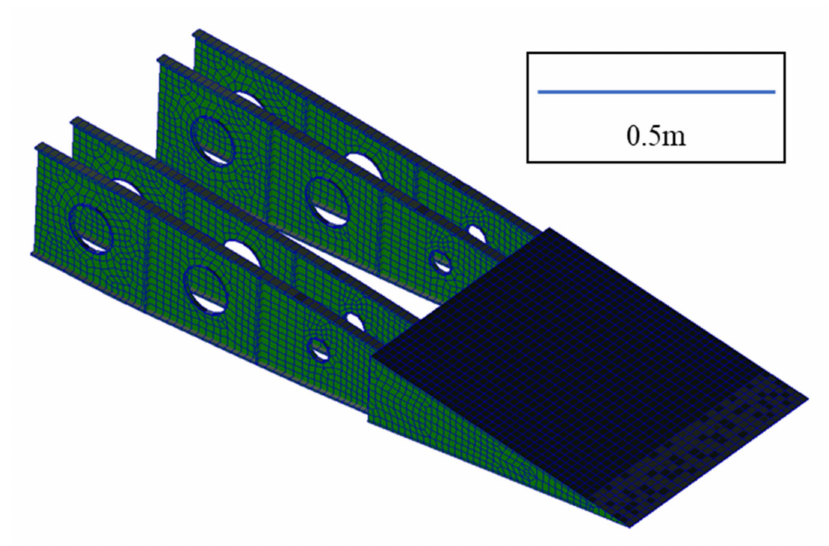
Figure 5. 3D FE model of flexible trailing edge model.